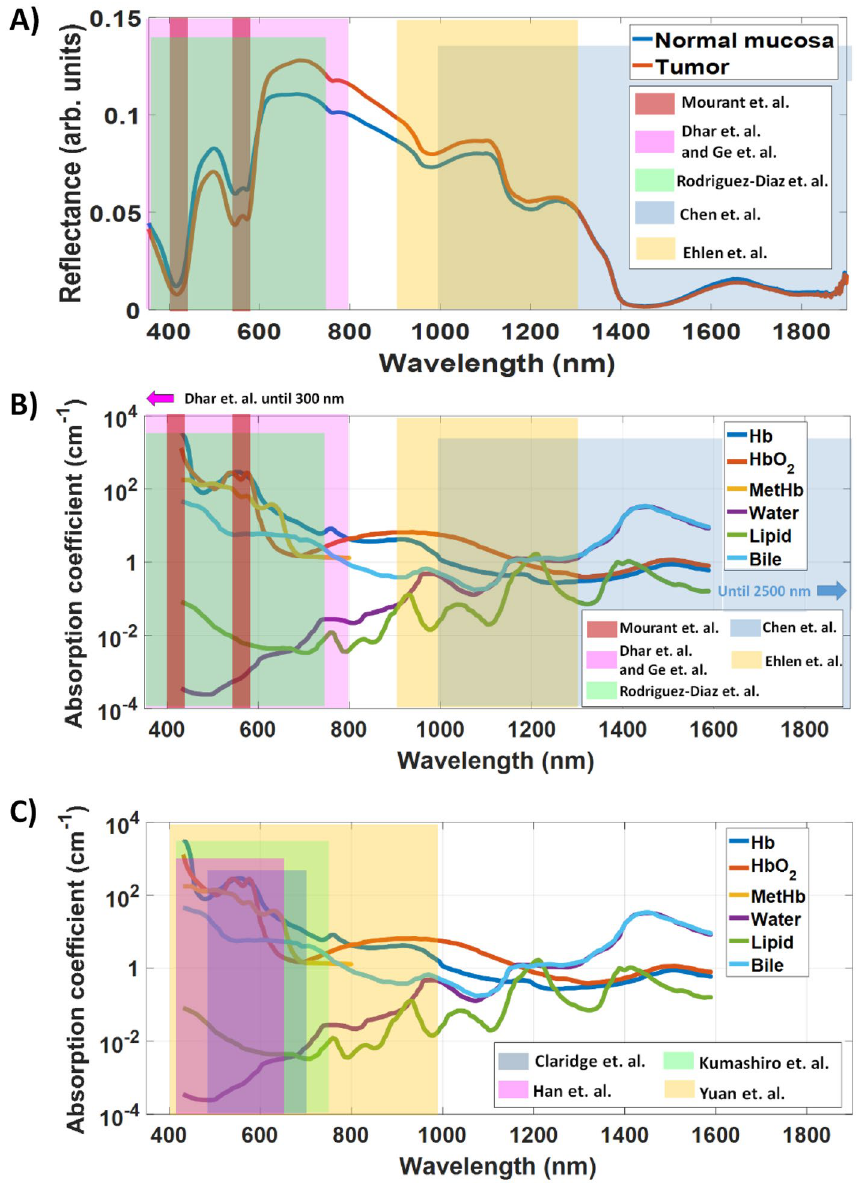
Figure 6. Wavelength ranges analyzed in previous DRS studies shown on the ( A ) mean spectra of normal mucosa and tumor (small SDD probe) collected in this study and ( B ) absorption spectra of endogenous tissue chromophores (biomolecules) 84 . ( C ) Absorption spectra of endogenous tissue chromophores showing the wavelength ranges investigated on previous hyperspectral imaging